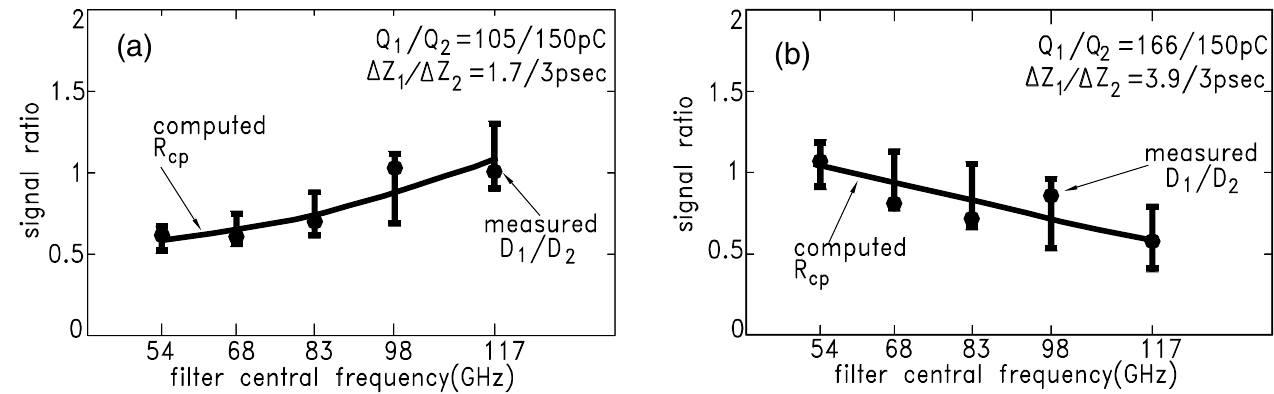
=D with the measured D for each channel (fixed wavelength) for two different bunch cp 1 2